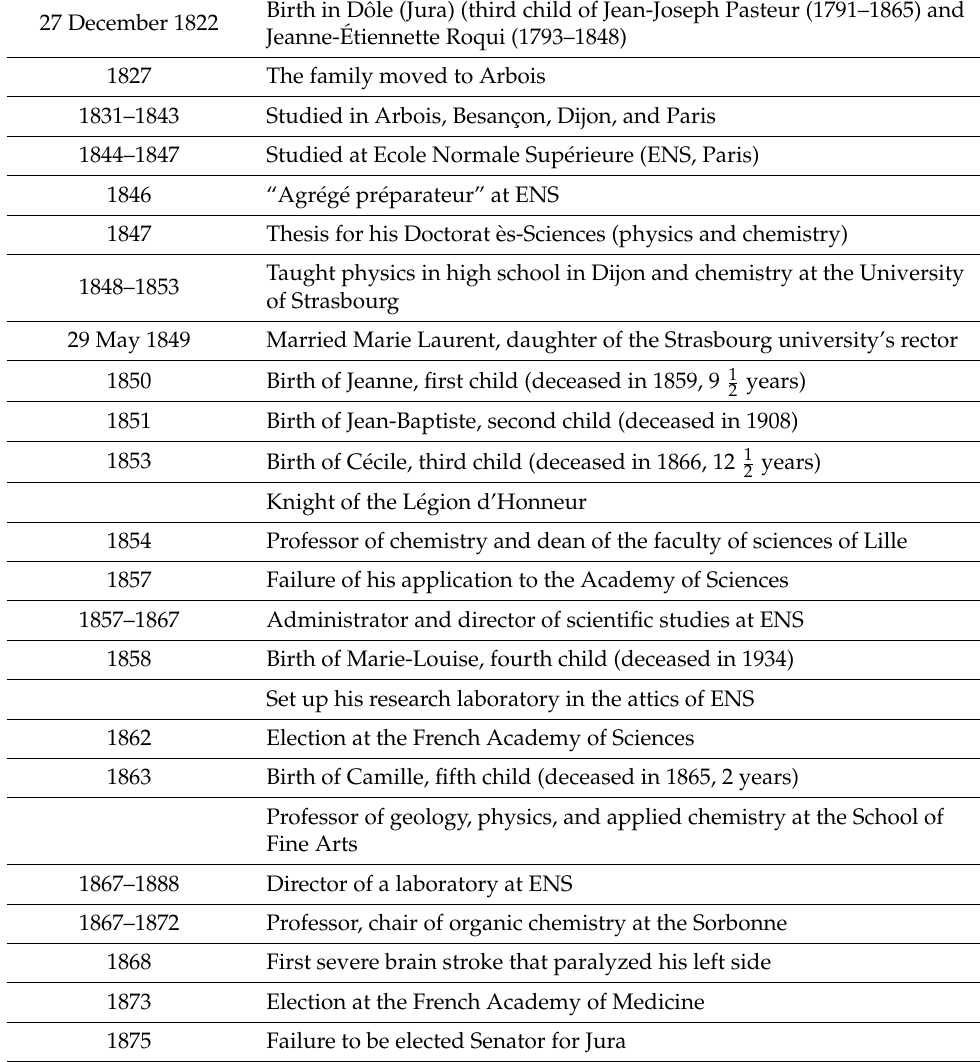
Table 2. Main steps of Louis Pasteur’s life and